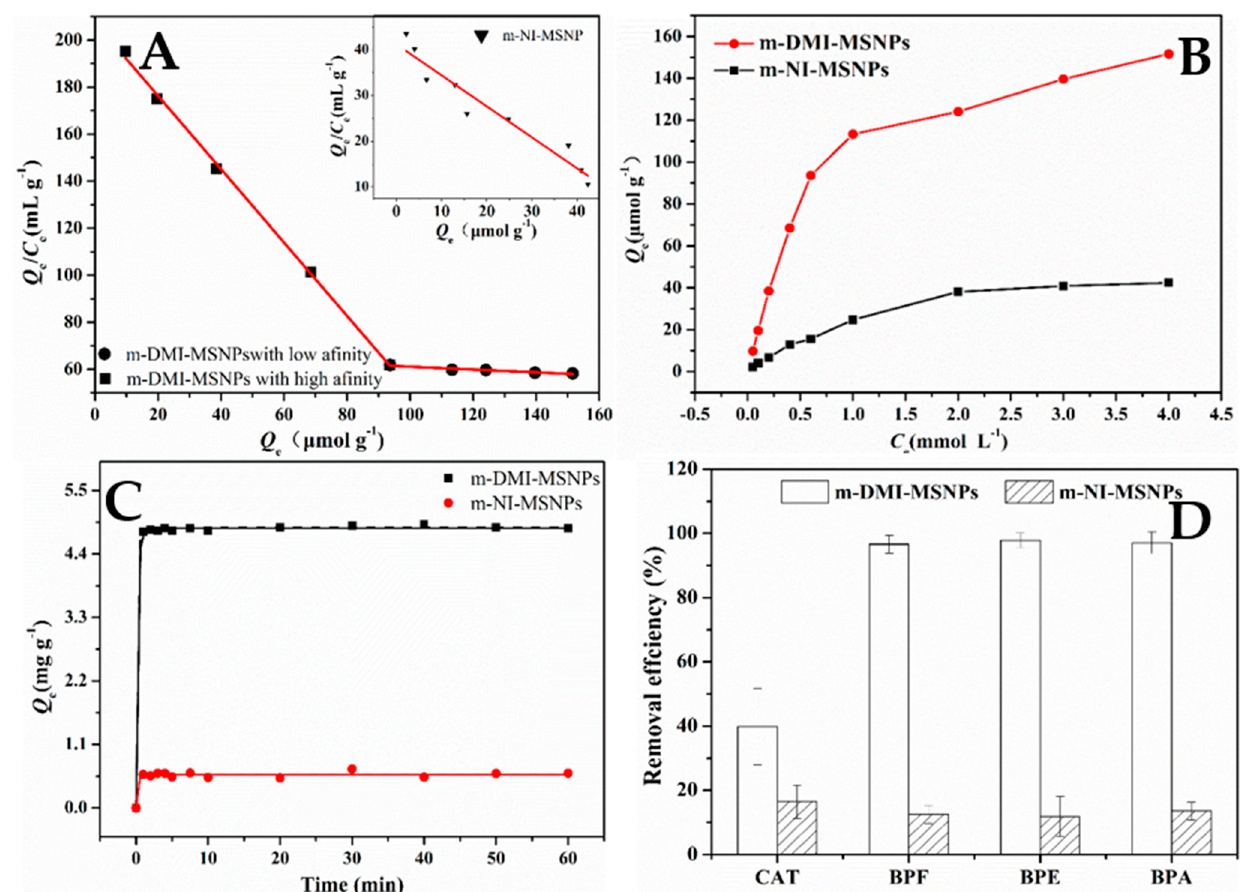
Figure 5. ( A ) Adsorption isotherms of BPA on m-DMI-MSNPs and m-NI-MSNPs, ( B ) Scatchard analysis for m-DMI-MSNPs and m-NI-MSNPs, ( C ) Adsorption kinetics of m-DMI-MSNPs and m-NI--MSNPs, ( D ) Removal efficiency of m--DMI--MSNPs and m-NI--MSNPs towards BPs. The bars represent the mean value ± standard deviation ( n = 3).